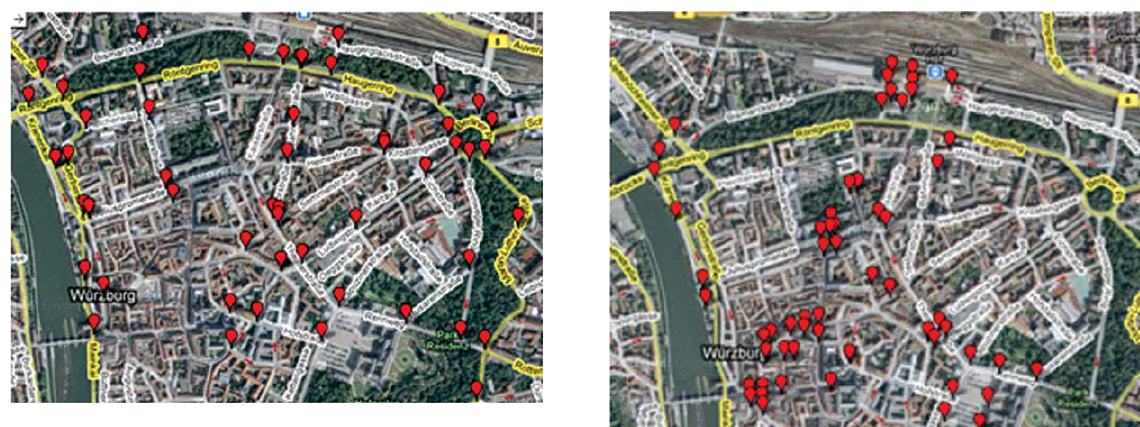
Fig. 10. Locations of digitized crosswalks.